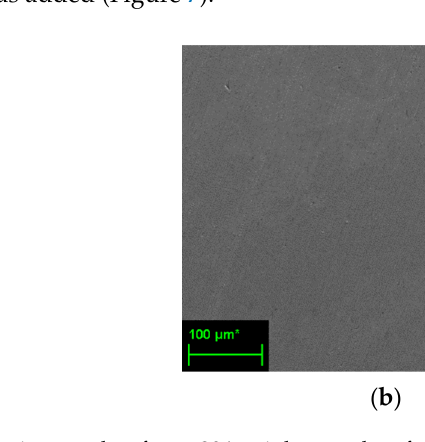
Figure 7. Scanning electron micrographs of type 304 stainless steel surface ( a ) without extract addition at 0.100 V SCE ( b ) with extract addition of 300 mg L − 1 at 0.100 V SCE .